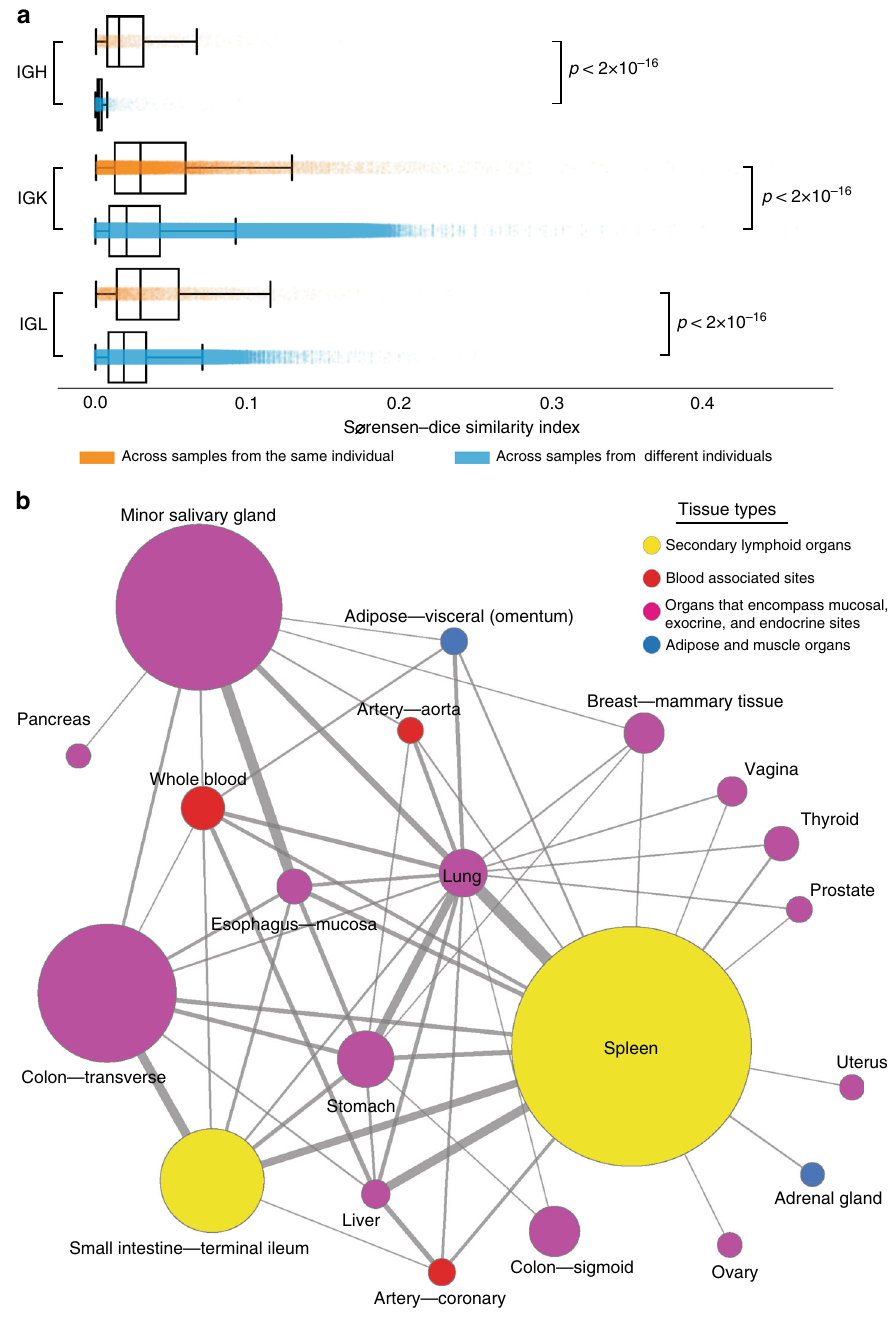
Fig. 5 The fl ow of Ig clonotypes across diverse human tissues. Results are based on pairs of tissues that are represented by at least 10 individual donors. a Box plots depicting the Sørensen – Dice similarity indexes for Ig clonotype sequences shared across samples from the same individual (orange color), IGH ( n = 1542, min = 0.0006, Q 1 = 0.0080, median = 0.0158, Q 3 = 0.0317, max = 0.2731), IGK ( n = 30498, min = 0.0005, Q 1 = 0.0131, median = 0.0297, Q = 0.0597, max = 0.4545), and IGL ( n = 5124, min = 0.0006, Q = 0.0142, median = 0.0299, Q = 0.0548, max = 0.3871); shared across samples 3 1 3 from different individuals (blue color), IGH ( n = 2988, min = 0.0004, Q 1 = 0.0016, median = 0.0025, Q 3 = 0.0041 max = 0.1463), IGK ( n = 10213560, min = 0.0002, Q 1 = 0.0091, median = 0.0208, Q 3 = 0.0424, max = 0.4615), and IGL ( n = 1484735, min = 0.0004, Q 1 = 0.0090, median = 0.0188, Q 3 = 0.0336, max = 0.2500). Only samples with at least ten reported clonotype sequences were used to compute Sørensen – Dice similarity indexes. Each boxplot represents the median and interquartile range, with whiskers extending to 1.5 times the interquartile range. The p -values were generated using a two-sided Mann – Whitney U -test for each chain (IGH: U = 417655.0, p -value = 0.0, IGK: U = 184067549896.0, p -value = 0.0, IGL: U = 4864609217.7, p -value = 5.03 × 10 − 261 ). b The fl ow of IGH clonotype across diverse human tissues is presented as a network. Each node represents a tissue; node size is proportional to the median number of clonotypes of the tissue. The color of the node corresponds to a type of the tissue: secondary lymphoid organs (yellow colors), blood associated sites (red color), and organs that encompass mucosal, exocrine, and endocrine sites (lavender color). Compositional similarities between the tissues in terms of gain or loss of CDR3 sequences are measured across valid pairs of tissues using a β -diversity (Sørensen – Dice similarity) index. Edges are weighted according to the β -diversity index. Edges with β -diversity scores > 0.001 are presented. Source data are provided as a Source Data fi